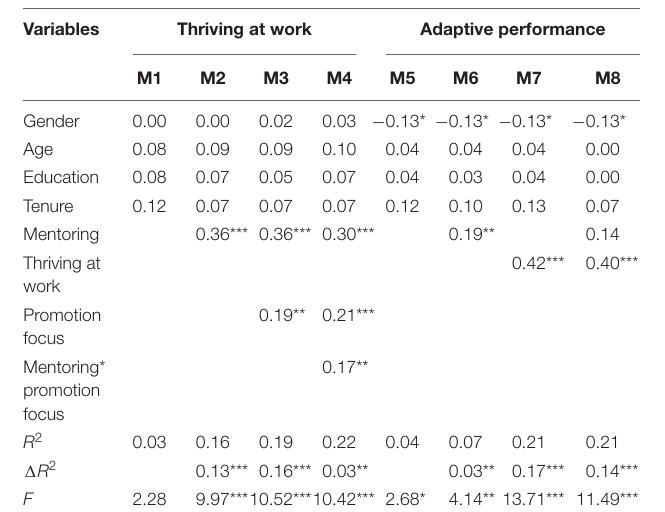
TABLE 2 | Hierarchical regression analysis results.